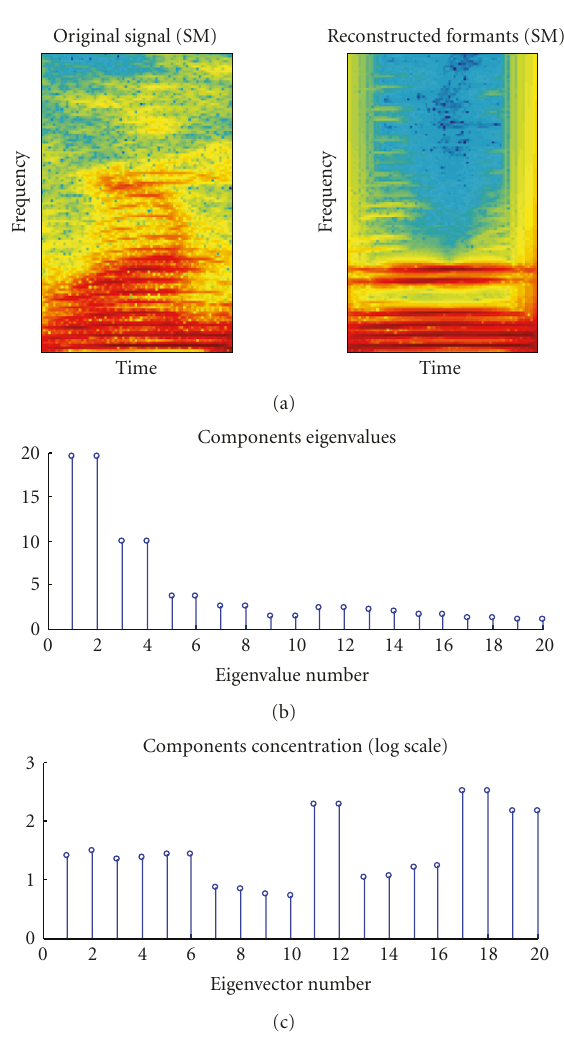
Figure 2: An illustration of the formants reconstruction by using the eigenvalues decomposition method.